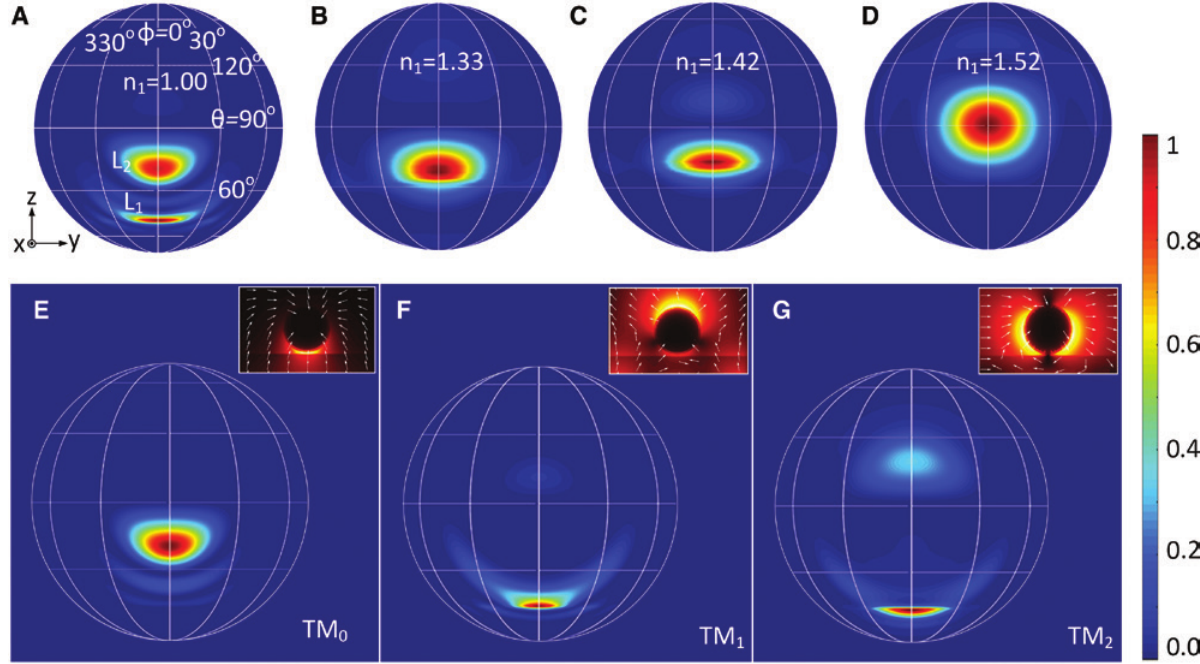
Figure 4: Far-field radiation patterns calculated by Green’s function method. (A–D) The calculated far-field radiation patterns projected onto the yz-plane by varying n bidirectional emission lobes. The grid lines indicate the spherical coordinate system. (E–G) The calculated far-field radiation patterns corresponding to three lowest-order modes (TM transverse electric near field intensity distributions (| E |) and vector plots of the three typical modes. The white arrows indicate field directions in the transverse